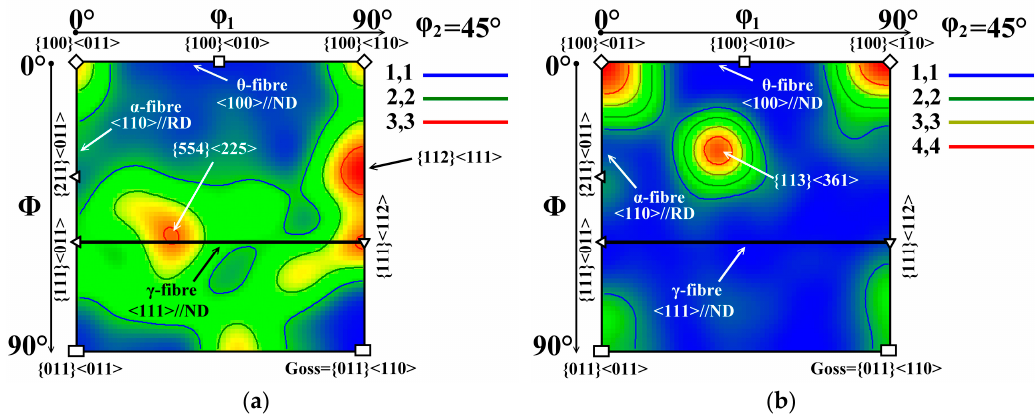
Figure 8. ODF sections taken at ϕ 2 = 45° representing the through-thickness textures evolved after heat treatment in long-term ( a ) and dynamic ( b ) heat treatment conditions.